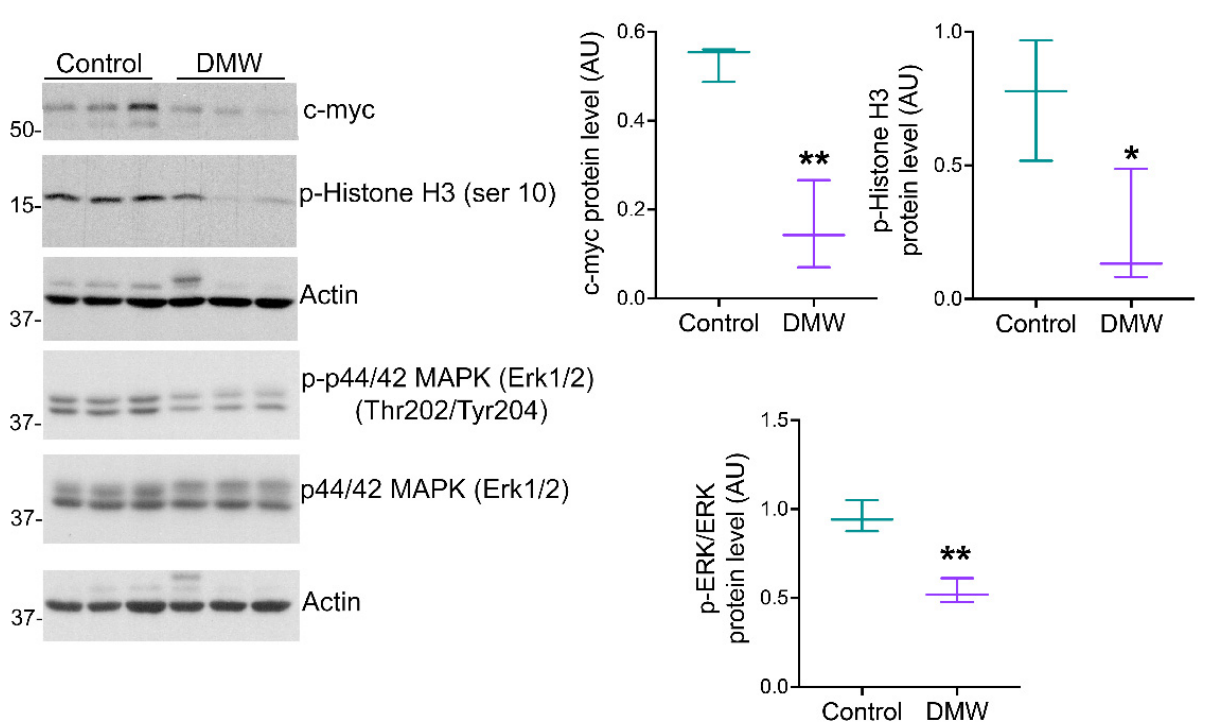
Figure 2. DMW downregulates the protein expression levels of proliferative markers. Western blot analysis showing the protein expression levels of c-myc, phospho-Histone H3 (ser 10), phospho- ERK, and ERK in xenograft tissue of DMW-treated mice and vehicle-treated mice. The right side of the panel shows the densitometry analysis of the above proteins. Signals were normalised on the housekeeping protein actin. Data represent the mean ± SEM of three tissues from vehicle- or DMW- treated mice. * p < 0.05, and ** p < 0.01 vs. control (vehicle-treated mice).